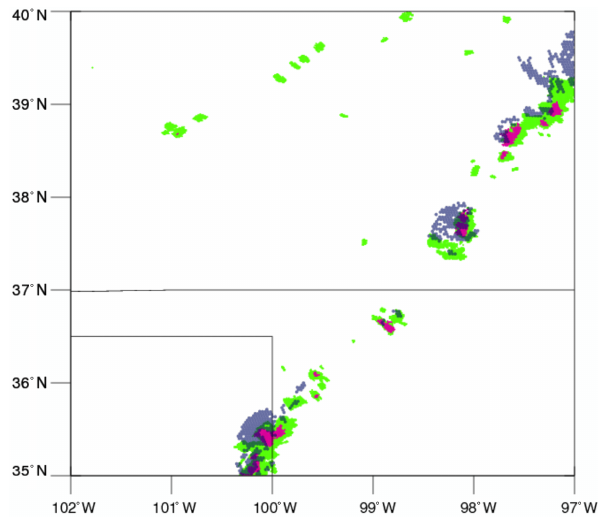
Figure 9. Plot of probability of detection (POD) and false alarm ratio (FAR) using different texture thresholds of the mature cloud detection method. The T b and reflectance thresholds are kept con- stant with 250K and 0.8,